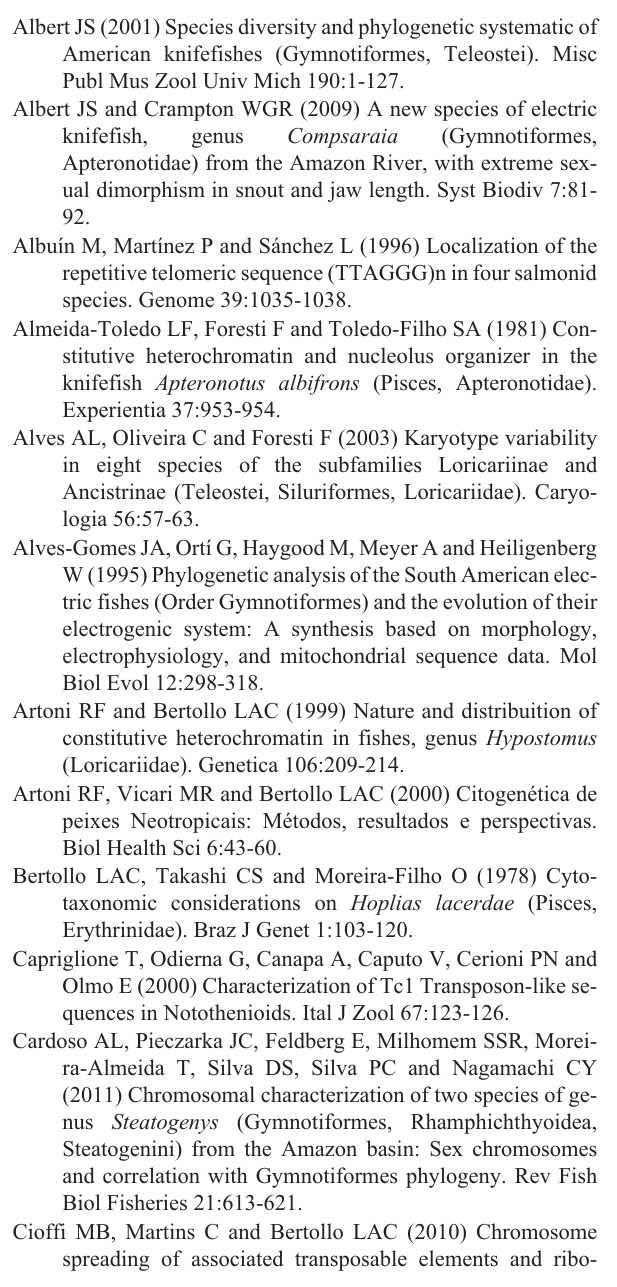
Figure 5 - Possible homeologies among Sternarchorhamphus muelleri, Parapteronotus hasemani and Sternarchogiton preto (conventional Giemsa staining and